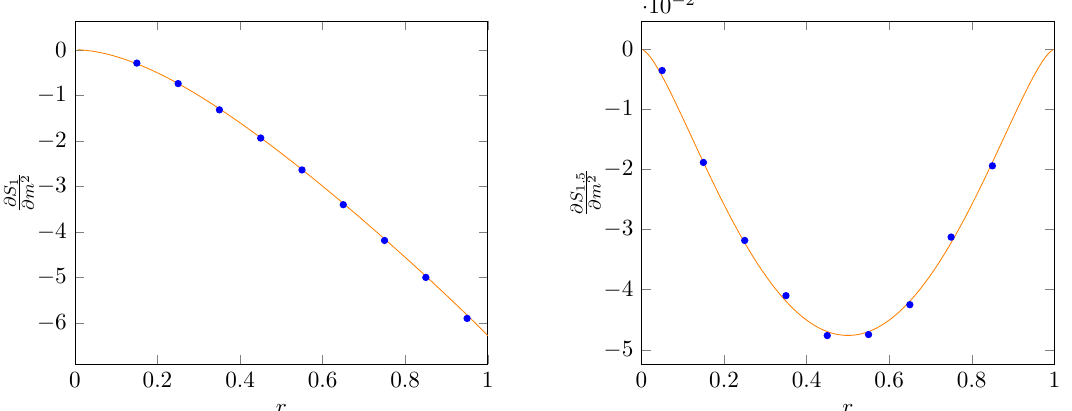
Figure 5 . Mass correction to the Rényi entropy as a function of the subsystems size, r for N = 300 sites. We compare the lattice results (continuous orange line) with eq. (4.13) (blue points) for a subsystem of one single interval, at β = 5 , in the spin sectors ν = 2 (left) and ν = 3 (right). We plot L the Rényi entropy S n corresponding to n = 1 for the ν = 2 spin sector, while we choose n = 1 . 5 for the ν = 3 spin sector. Notice that in this case we used the symbols for the field theory prediction, since the evaluation of the integrals defining this correction makes it hard to sample many points; for visual clarity, we used instead a continuous line for the lattice data. The overlap between the field theory and the lattice theory is obtained by a fit of a multiplicative constant for the data, due to a renormalisation of the